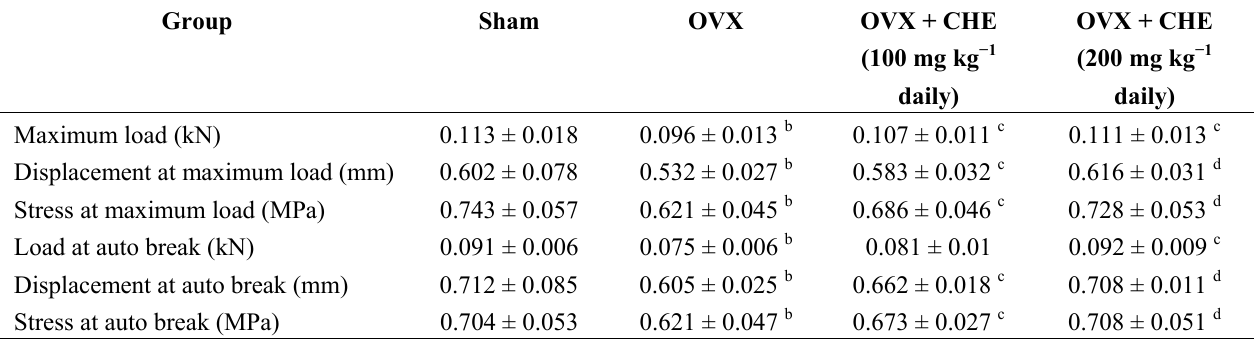
Table 2. Effect of Cistanches Herba extract treatment on bone biomechanical